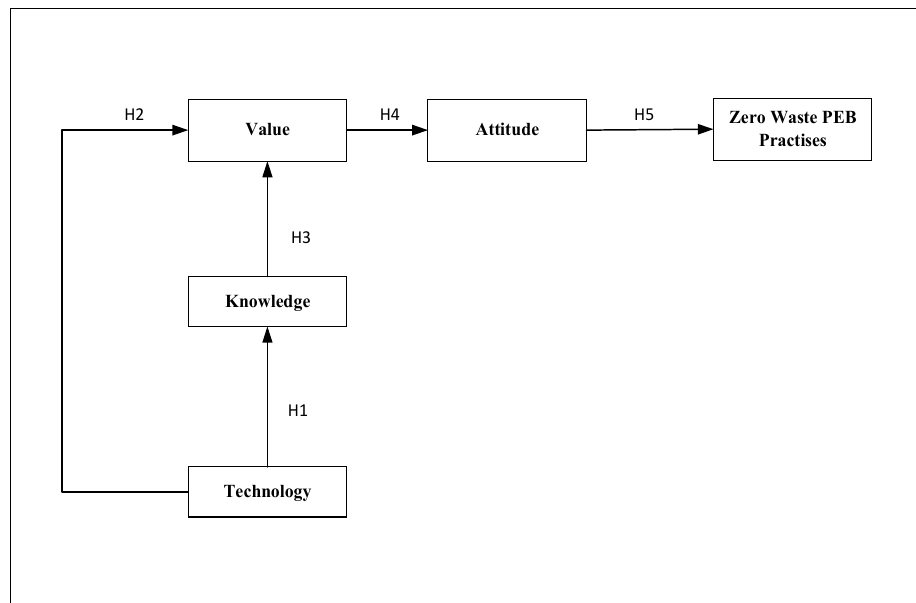
Figure 8. Research